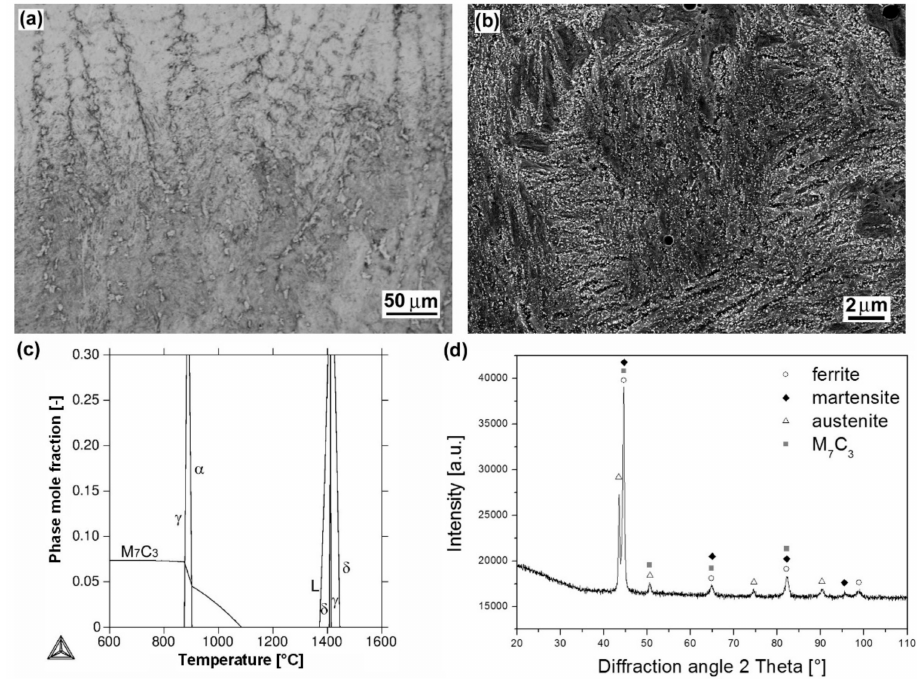
Figure 4. Characterization of “LNM 420FM” hardfacing: overall microstructure visualized by LOM ( a ); detailed microstructure visualized by SEM ( b ); thermodynamic calculation of equilibrium phase composition depending on temperature ( c ); XRD-pattern representing experimentally determined phase composition ( d